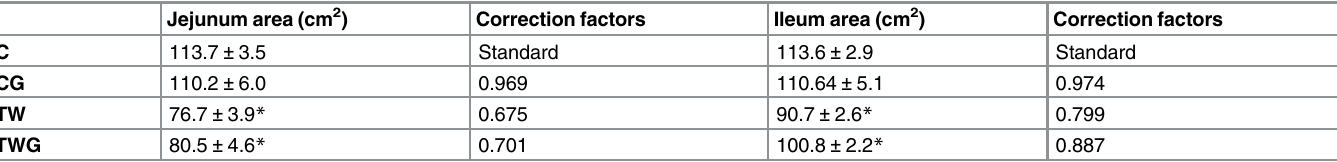
Table 2. Average area of the small intestine and correction factors applied for the of neuronal density correction in the myenteric and submucosal plexuses of the jejunum and ileum. Experimental groups: control (C); control supplemented with 2% L-glutamine (CG); Walker-256 tumor (TW); and Walker-256 tumor supplemented with 2% L-glutamine (TWG). n = 8 rats per group.